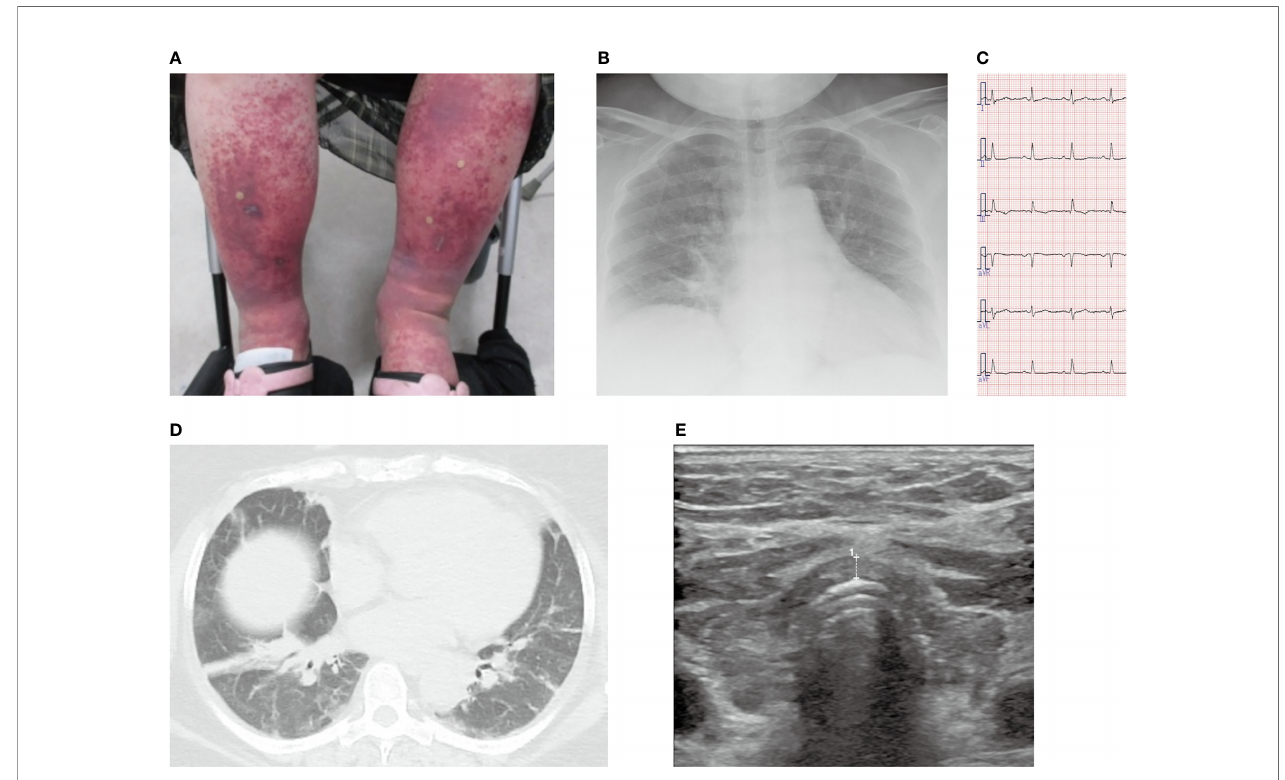
FIGURE 1 | Images of the lower legs, chest X-ray, chest computed tomography, electrocardiogram, and echocardiogram. (A) Purpura and edema on both lower legs. (B) Chest X-ray on admission showed mild pulmonary congestion. (C) No abnormalities were found on the electrocardiogram at the time of admission. (D) Chest computed tomography showed atelectasis and mild pulmonary congestion. (E) Thyroid echo showed diffuse atrophy of the thyroid gland, irregular surface, and rough and low echo levels inside the thyroid gland. The thickness of the isthmus is 2.6 mm in diameter, which is indicated as broken line